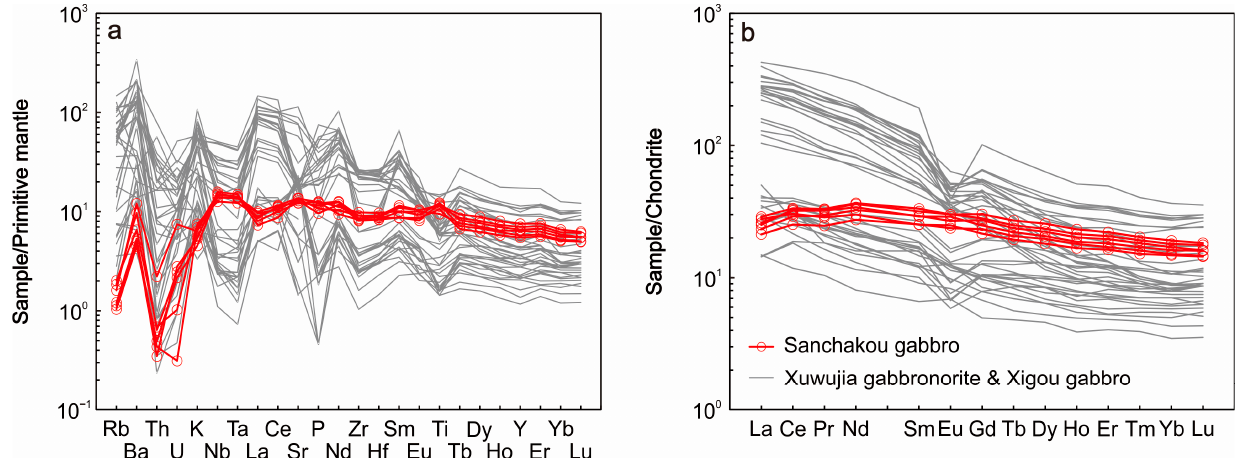
Figure 7. Chondrite-normalized REE ( a ) and primitive mantle-normalized trace element ( b ) patterns for the Sanchakou gabbros. The normalization values are from [79]. The trace elemental data of Xuwujia gabbronorites and Xigou gabbros are from [35].